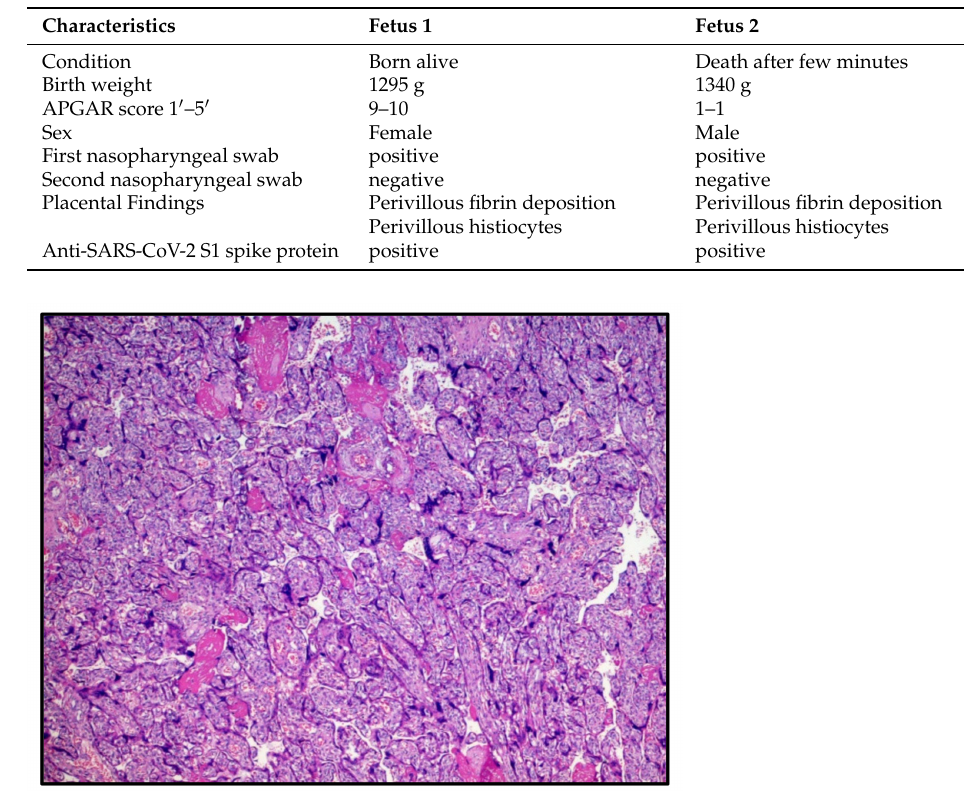
Table 1. Features of twin pregnancy.